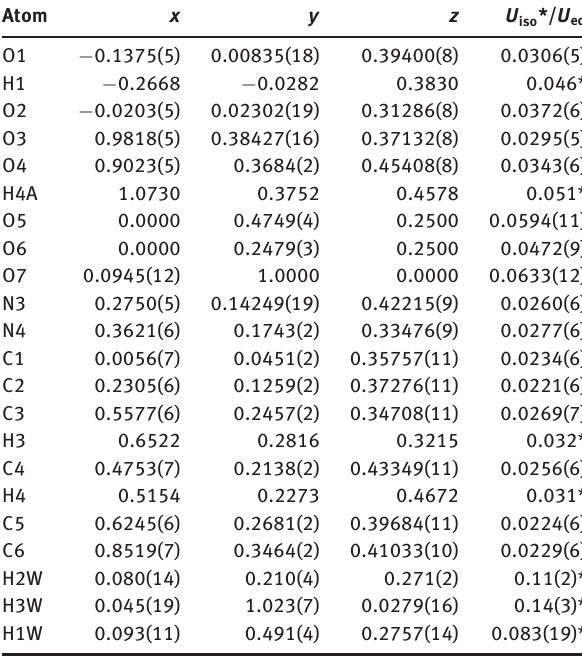
Table 2: Fractional atomic coordinates and isotropic or equivalent isotropic displacement parameters (Å 2